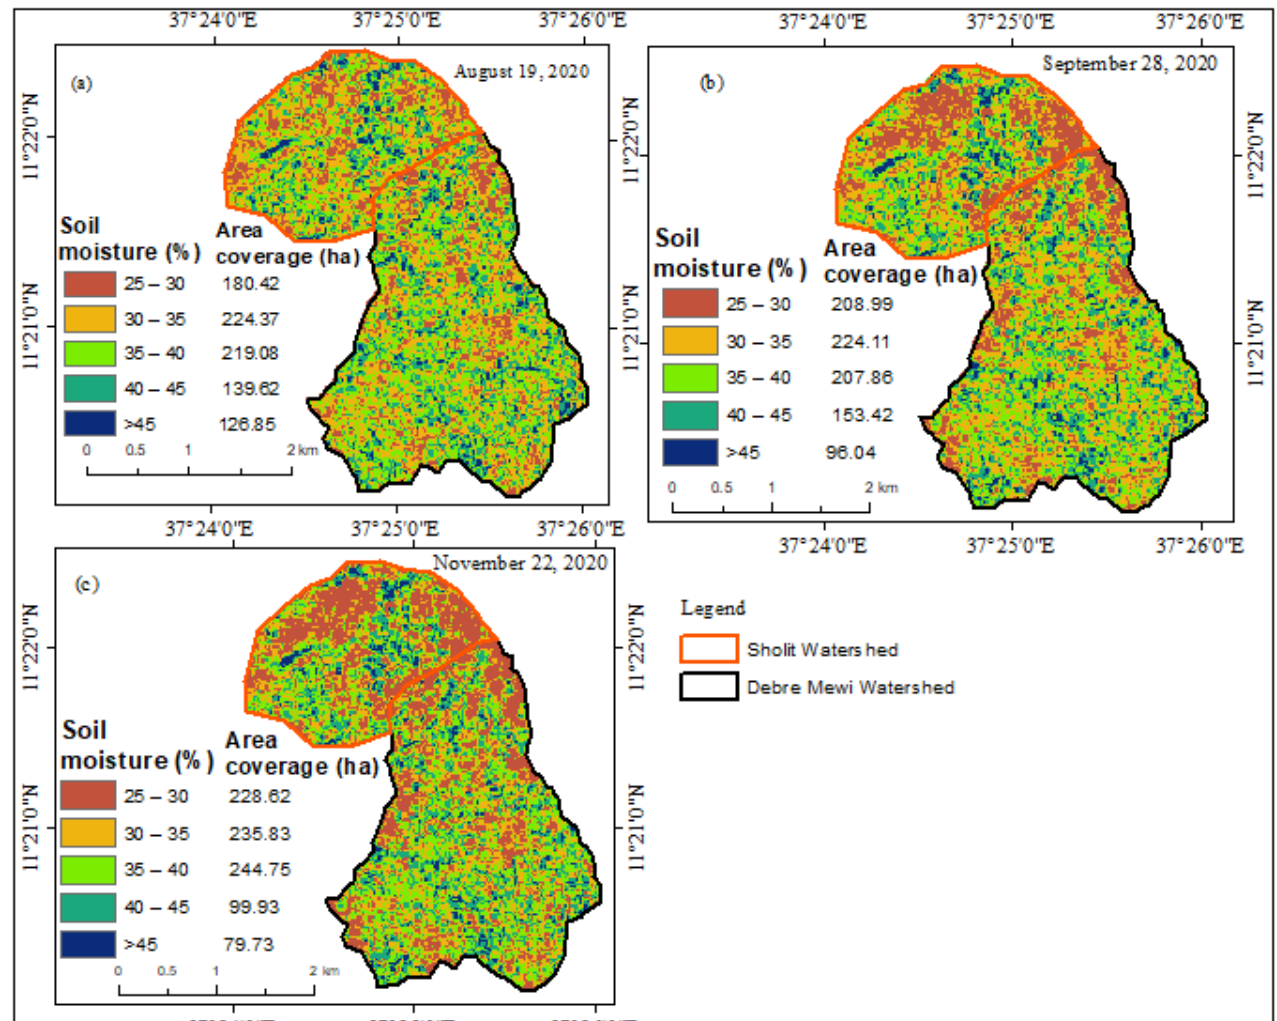
Figure 6. Soil moisture class and the area coverage (in ha), derived from WCM ( a ) August 19 (early vegetative phase), ( b ) September 28 (reproductive phase), and ( c ) November 22 (ripening phase).